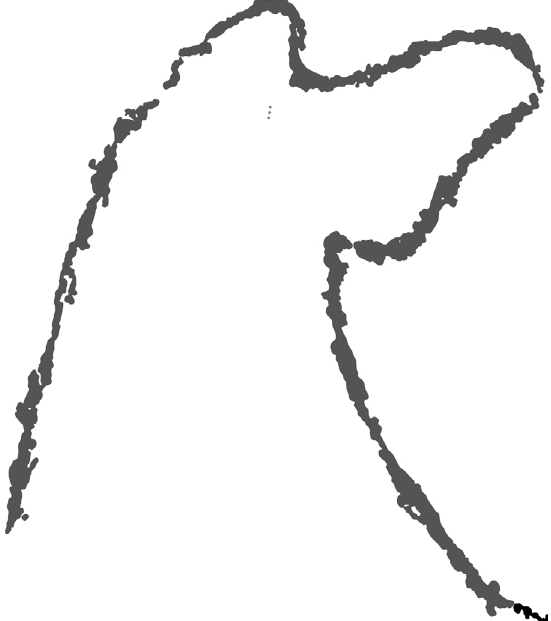
Figure 16. Incomplete but hoofed motif (probably a horse) at Fariseu Rock 1 Tracing: Fernando Barbosa, assisted by Manuel Almeida, João Félix and André Tomás Santos.